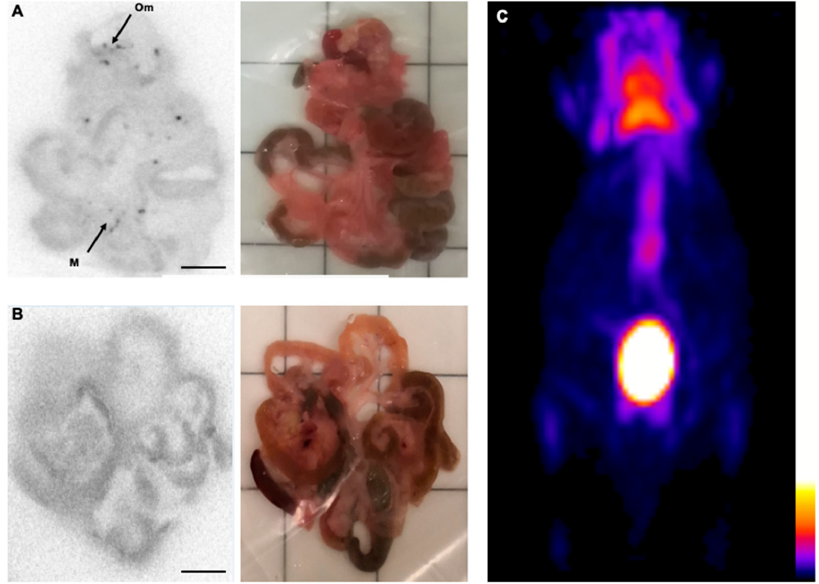
Figure 1. Intraperitoneal FDG is superior for the detection of intravenously administered molecules in the early stage Bc.DLFL1 mouse lymphoma model. Ex vivo autoradiographic detection of the tumor cells 24 h post-intraperitoneal inoculation. The FDG injections revealed that cells adhered to the omentum (Om) and mesentery (M) placed on the ARG cassette ( A ). Scale bar represents 1 cm in the images. Intravenous administration of the radiotracer failed to identify mesentery- and omentum-associated lymphoma cells ( B ). The corresponding white light image panel is also presented for orientation purposes. The lack of a tumor-derived signal 24 h after lymphoma inoculation is shown with a PET three dimensional maximal intensity projection reconstruction acquired 2 h after intraperitoneal FDG application ( C ). Only normal FDG mouse distribution is visible in the PET image, its color scale representing radioactive concentrations in